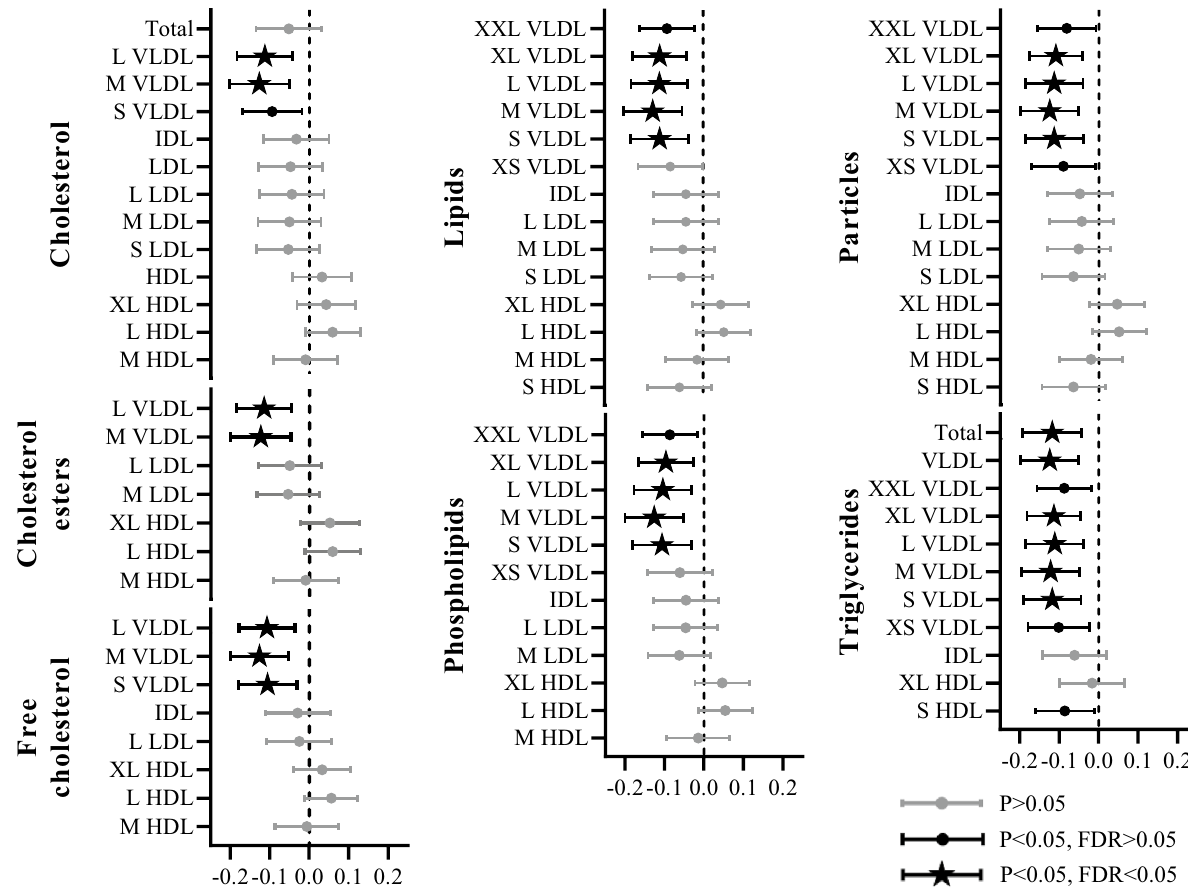
Figure 2. Associations of blood hsa-miR-29b-3p levels with serum lipoprotein subclass particle size and lipid components. The serum lipoprotein subclass particle size and lipid components measured by NMR- spectroscopy. Values are standard deviation (SD) increment in metabolite measure and 95% confidence intervals (95% CI) per one SD change of miRNA of interest are presented. Associations have been analyzed with a linear regression model adjusted with age, sex, smoking, birth status, liver status, polygenic risk score for metabolic syndrome and blood cell counts (MODEL 2). n for the model is 551. XL extra large, L large, M medium, S small, XS extra small, HDL high-density lipoprotein, LDL low-density lipoprotein, IDL intermediate-density lipoprotein, VLDL very-low-density